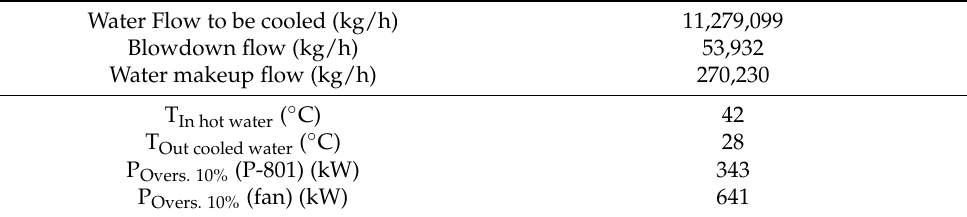
Table 12. Cooling tower